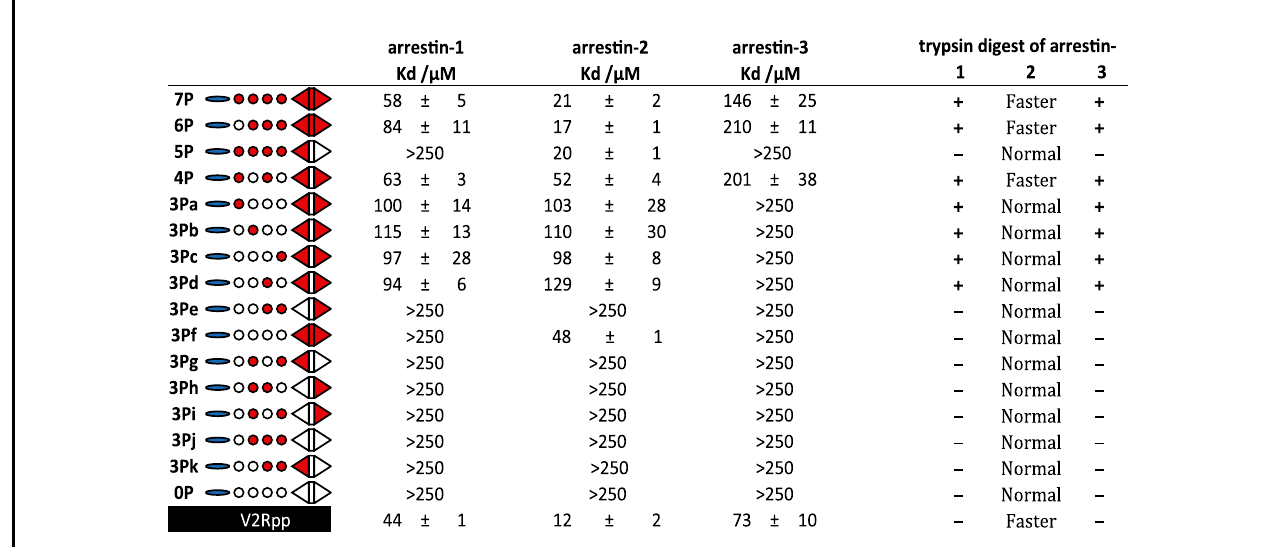
Table 2 Summary of determined af fi nities and trypsin digestion